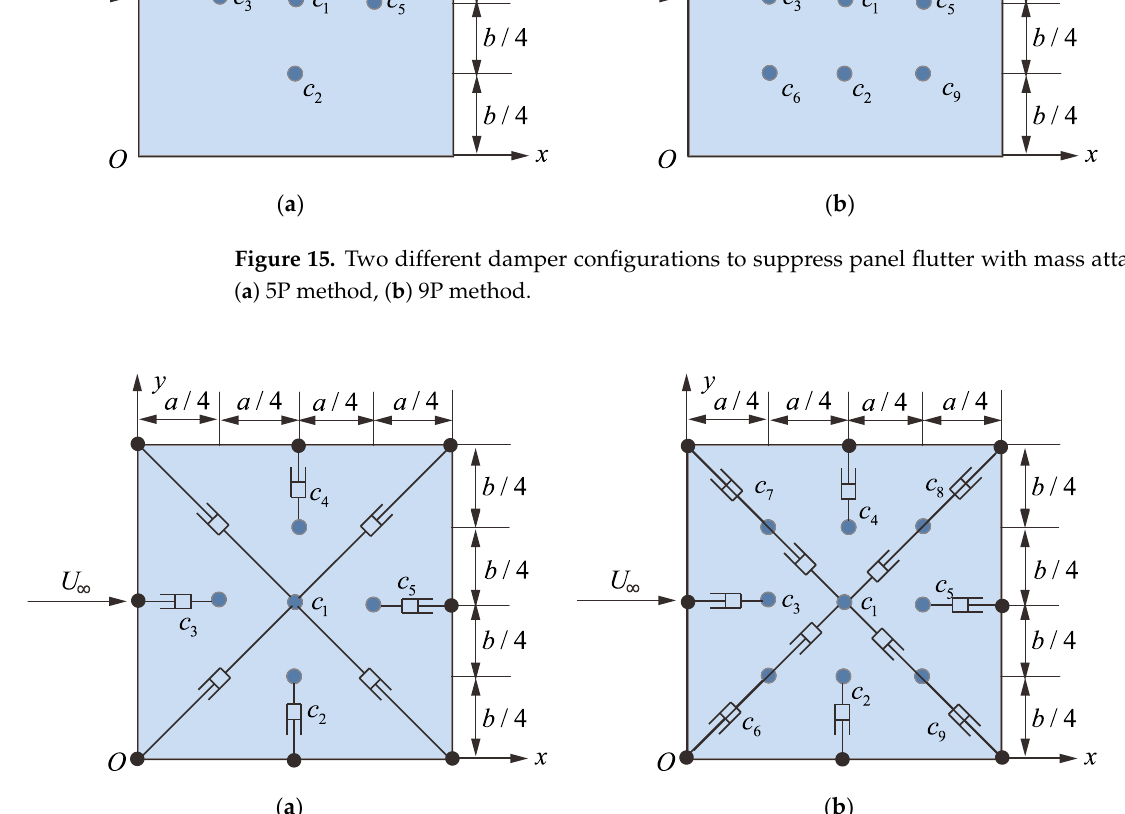
Figure 16. Two different damper configurations to suppress panel flutter with mass attachments: ( a ) 5P method, ( b ) 9P method.